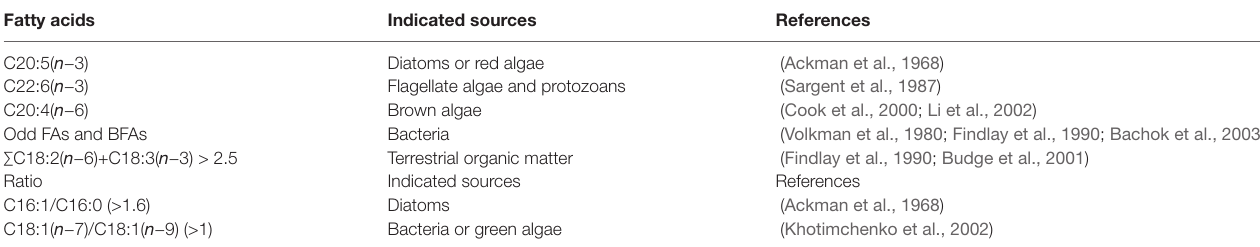
TABLE 5 | Fatty acids and fatty acid ratios were used as biomarkers for food sources. Fatty acids